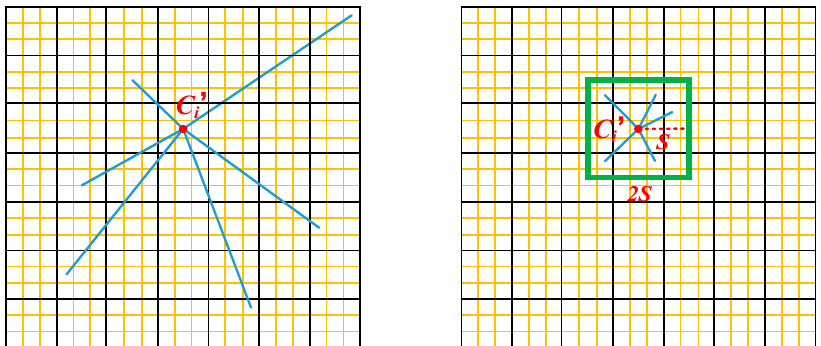
Figure 5. The sketch map for the difference of global k -means and local k -means.